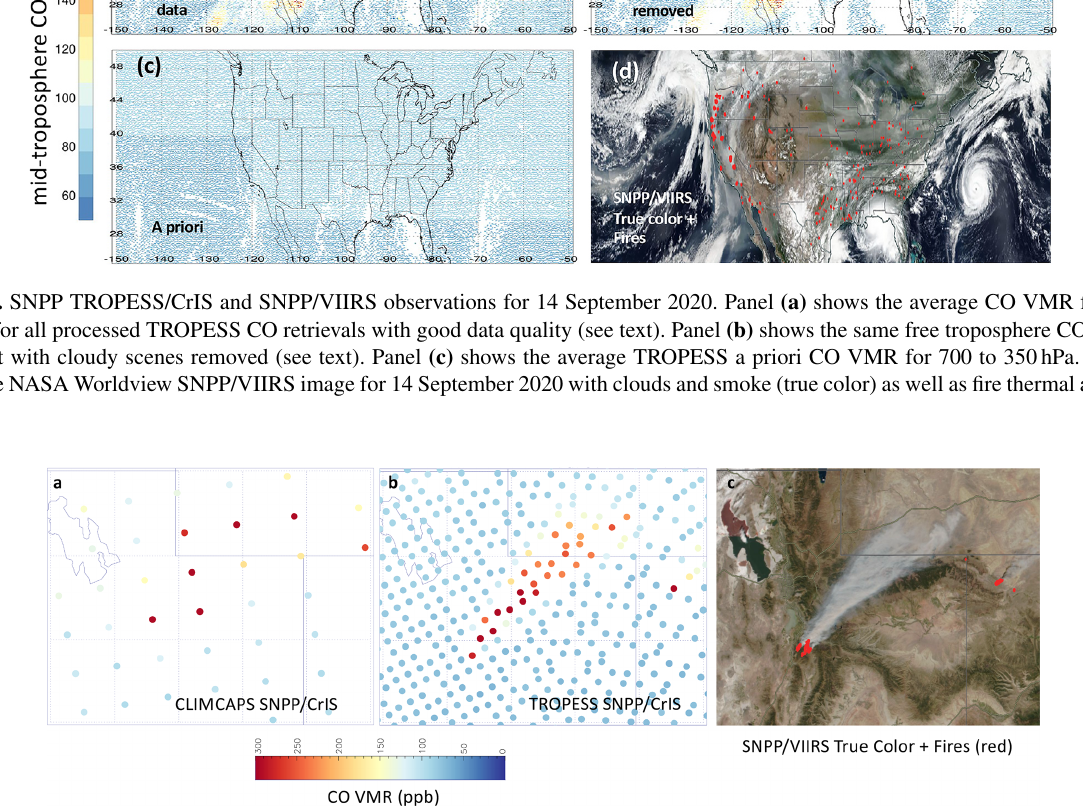
Figure 2. SNPP observations of the Pole Creek fire in Utah, USA, on 13 September 2018. The Great Salt Lake is in the upper left of each panel, and state borders with Idaho, Wyoming, and Colorado are indicated by solid straight lines. Dotted lines indicate a 1 ◦ latitude by 1 ◦ longitude grid, with the top left corner at 42 ◦ N, − 113 ◦ E. Panel (a) shows CLIMCAPS/CrIS CO at 500hPa (MMR converted to VMR). Panel (b) shows the TROPESS/CrIS tropospheric CO column average VMR, and panel (c) shows the corresponding NASA Worldview SNPP/VIIRS image with clouds and smoke (true color) as well as fire thermal anomalies